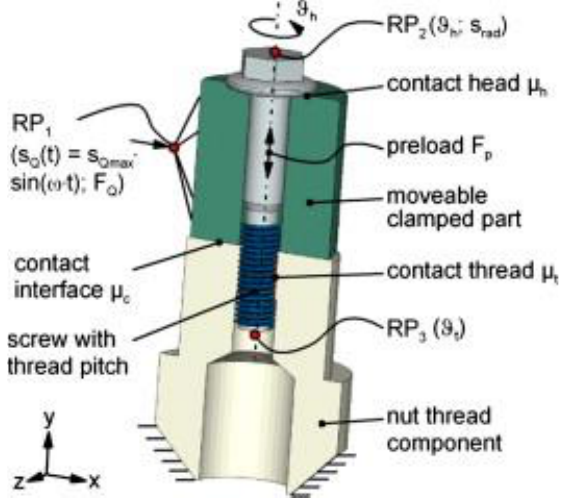
Figure 2. Finite element model of the bolted connection using the localized slippage theory [38].